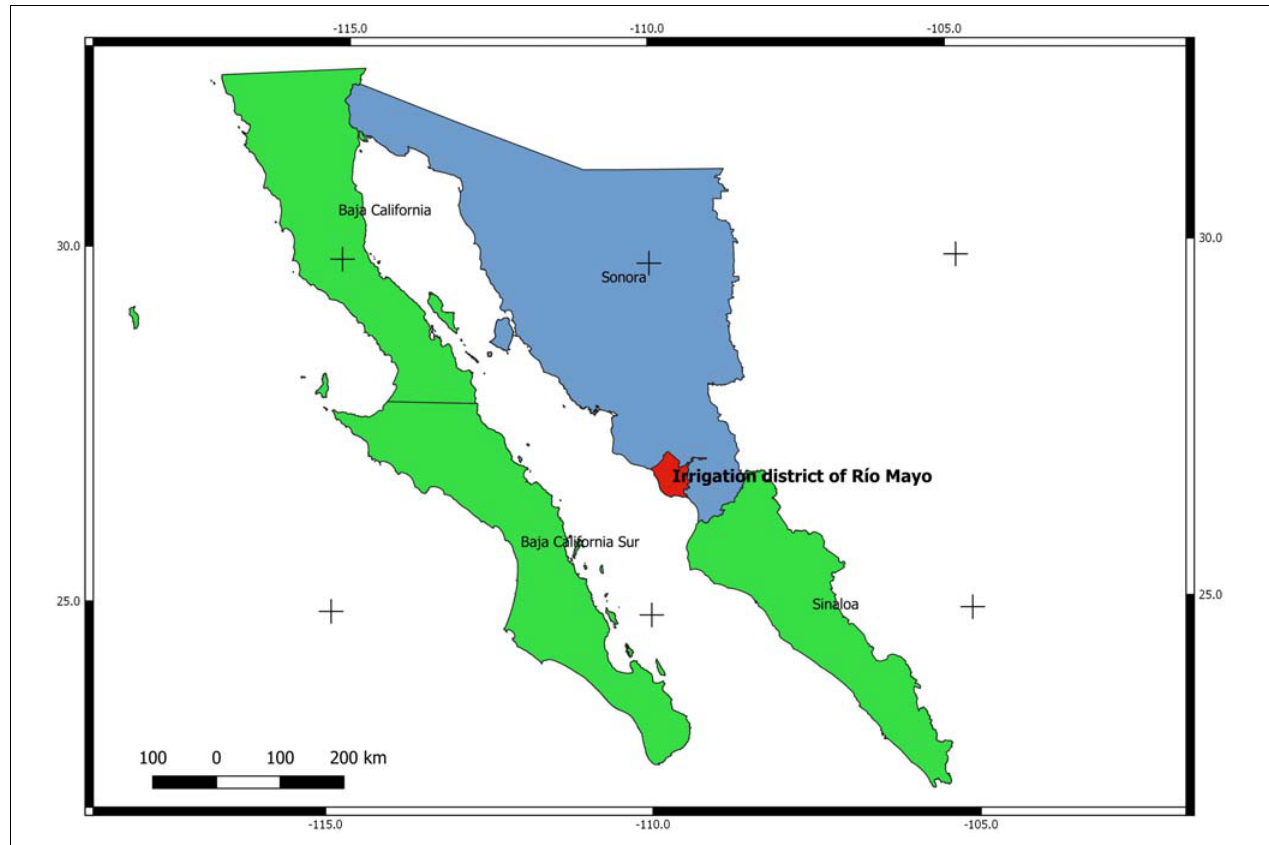
FIGURE 1 | Study zone Irrigation District of Río Mayo, located in the southwest of Sonora and draining directly to the Gulf of California.